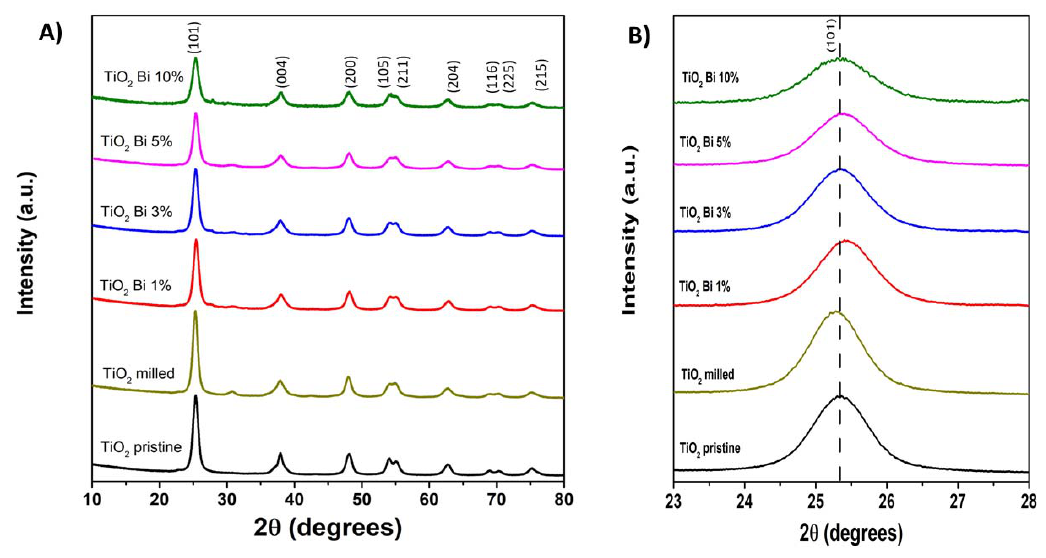
Figure 6. XRD patterns of the TiO 2 and the milled samples with different bismuth content ( A ), and amplification of the (101) peak from the anatase patterns ( B ).